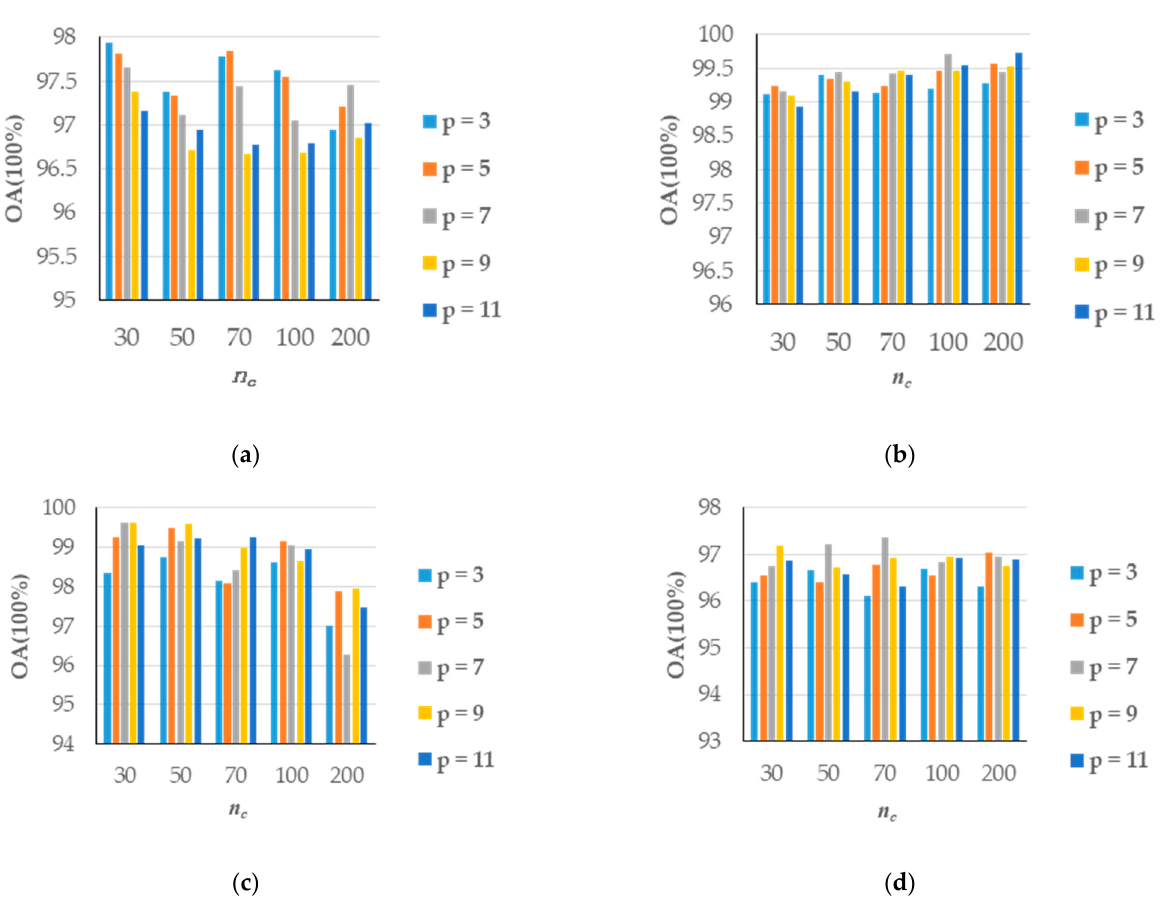
Figure 5. OA obtained on four datasets with different number of superpixels and patch size ( a ) IP, ( b ) PU, ( c ) SA, and ( d ) HU.